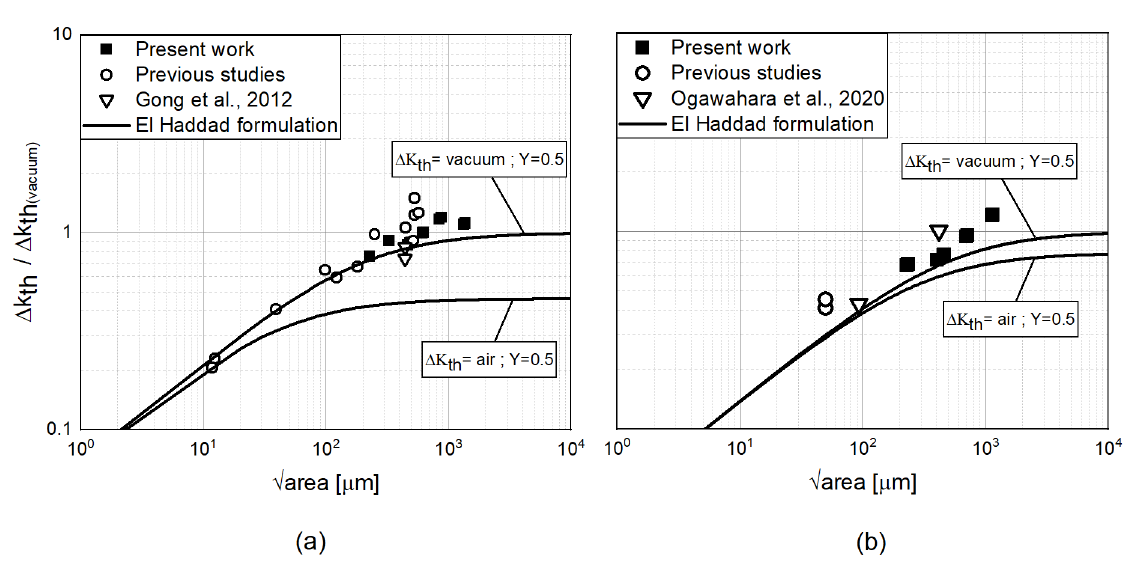
Figure 11. Kitagawa diagram for both Ti6Al4V ( a ) and Inconel 718 ( b ) showing experimental data points that survived more than one million cycles. Data points from literature were also used (Gong et al., 2012 [17], Ogawahara et al., 2020 [4]